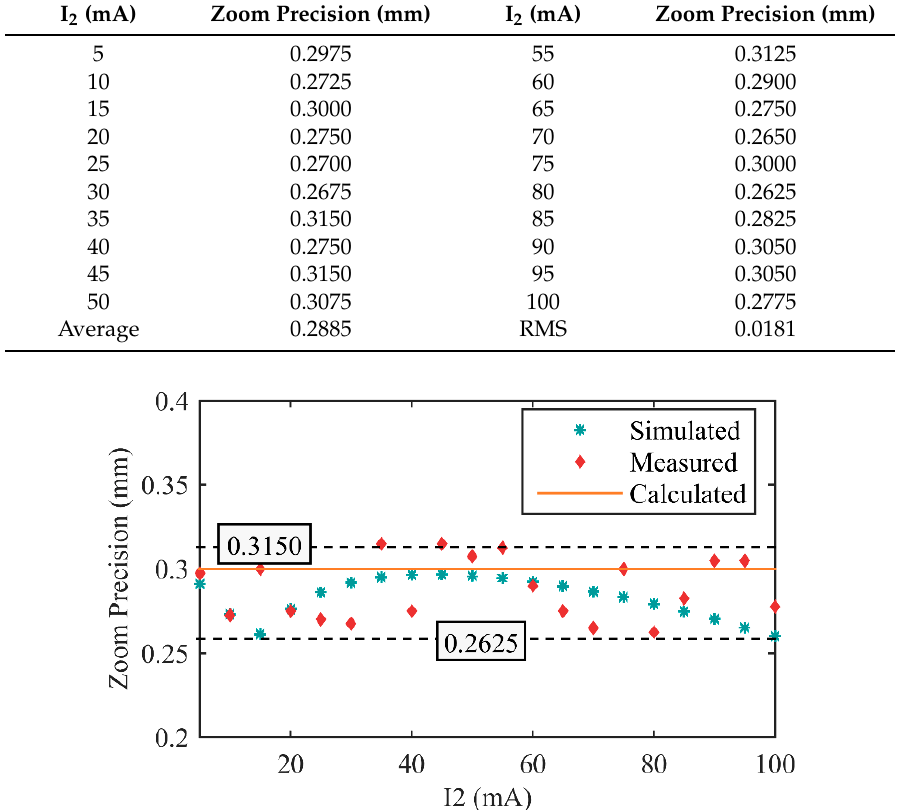
Figure 11. Zoom precision comparison among calculated, simulated, and measured values. Zoom precision of the realized zoom system is approximately uniform in the whole zoom process. The average of measured zoom precision is 0.2885 mm, near to the calculated value 0.3 mm, and all of measured values are in the range of ±0.0265 mm to average zoom precision, RMS of the